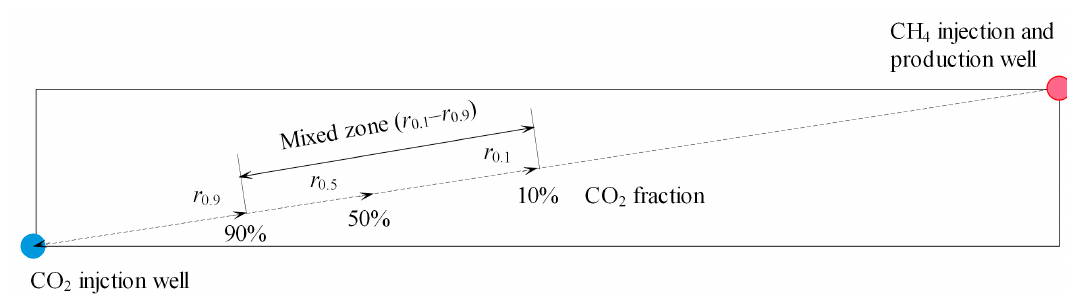
Figure 7. Schematic diagram of the mixed zone in the diagonal section of the reservoir.